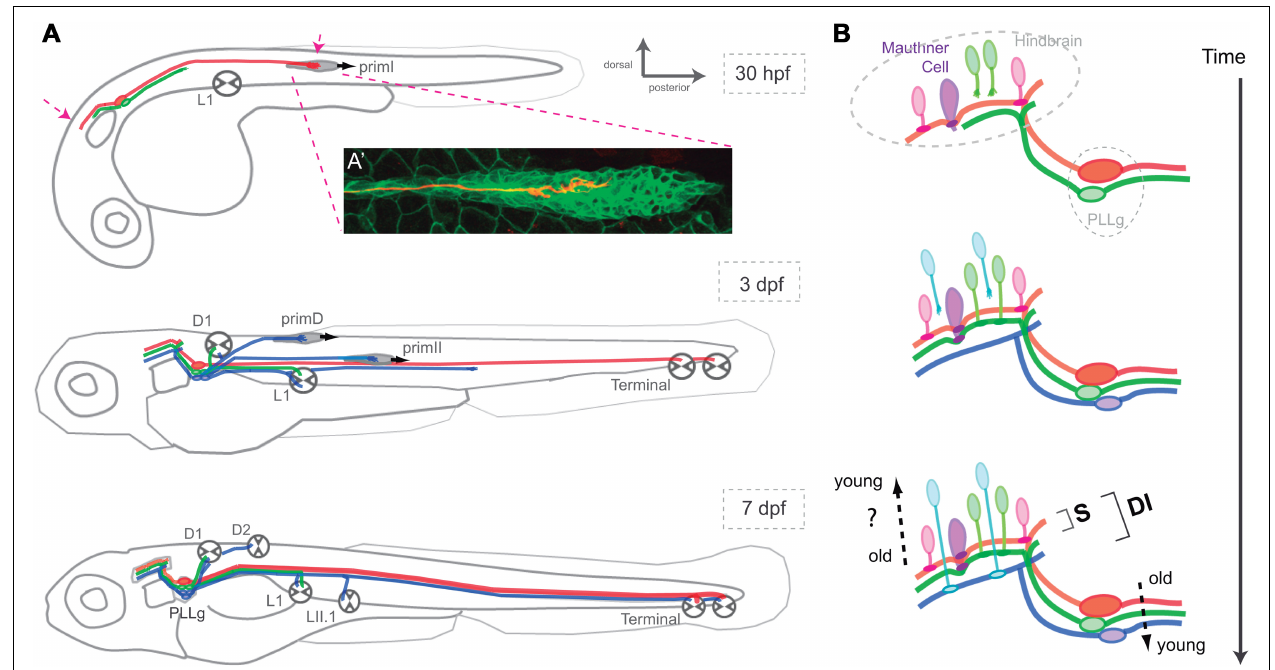
FIGURE 2 |Assembly of the posterior lateral-line neural map. (A) Lateral view of a developing zebrafish at around 30 hpf, 3 and 7 dpf showing the coincident progressive development of the lateralis afferents and their peripheral targets. Arrows at 30 hpf indicate growing lateralis afferent’s central and peripheral axons. PLLg: posterior lateralis ganglion formed by the lateralis afferent’s cell bodies. (A’) A single lateralis afferent neuron is labeled in red in a transgenic zebrafish embryo expressing GFP in primI.The peripheral axonal growth cone can be observed within the migrating primordium. (B) Lateral view of the developing hindbrain and lateralis afferent’s central axons at around 30 hpf, 3 and 7 dpf depicting an hypothetical temporal code that matches lateralis afferents with second-order neurons that are born at similar